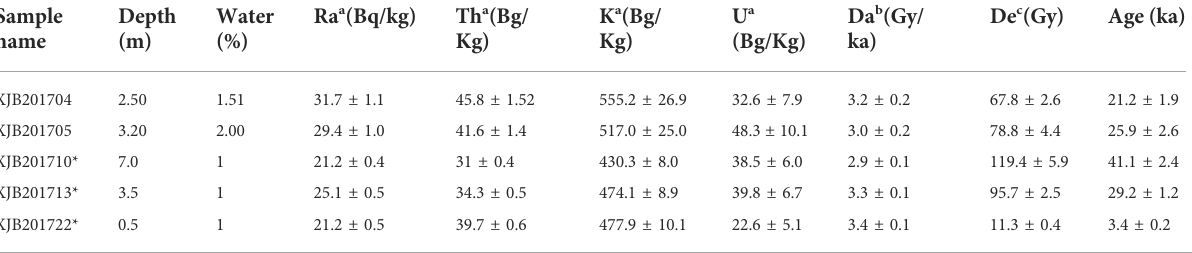
TABLE 2 Summary of luminescence dating results from the Xujiabao pro fi le on the